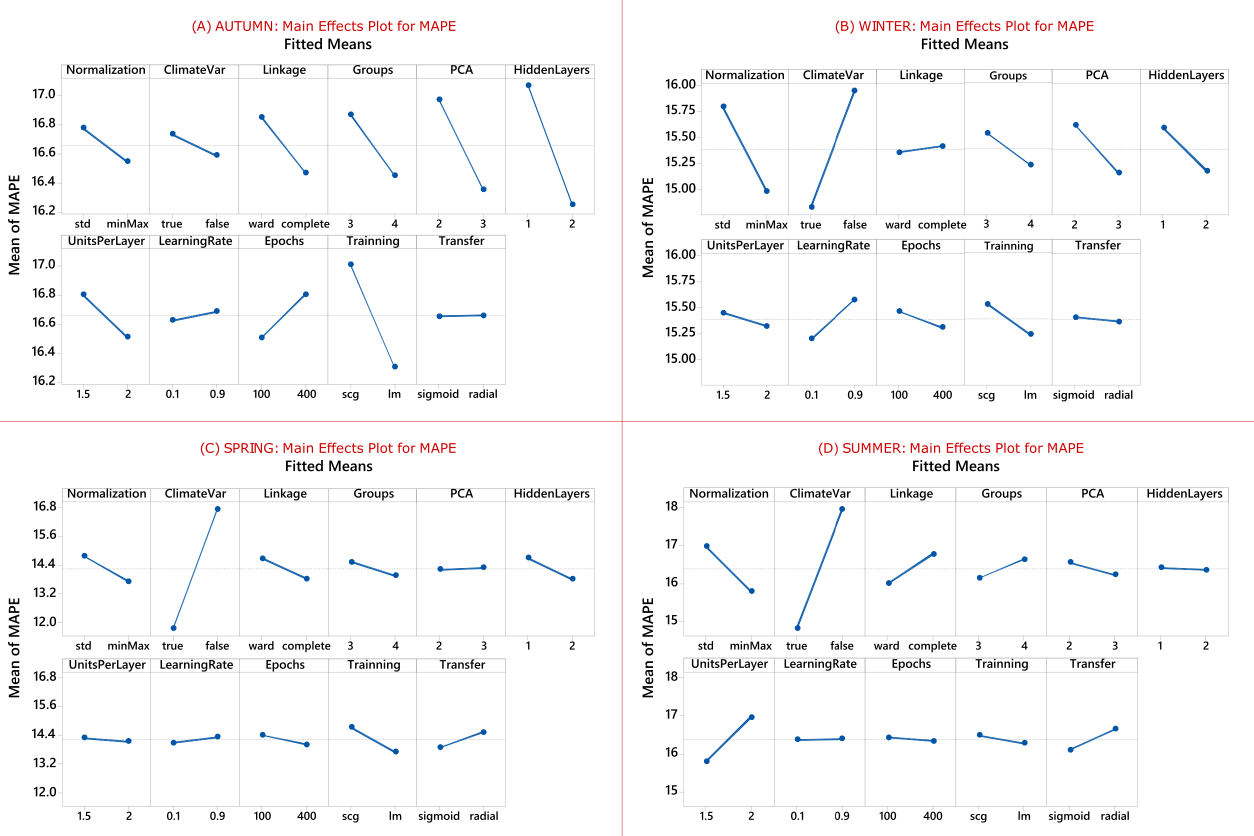
Figure 12. Main effects plot for each season, considering the average error of all seventeen genera- tion plants. Source: own authors. plants. Source: own